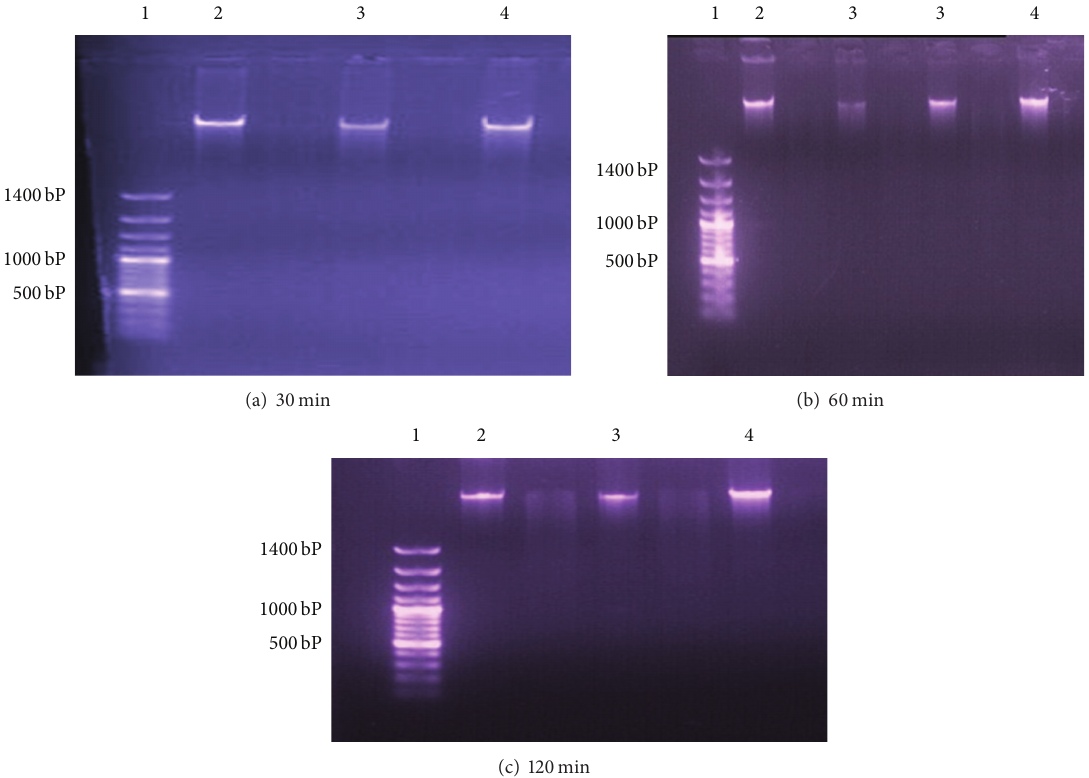
Figure 1: Showing the agarose gel electrophoresis of the isolated DNA of the parasites after incubating the blood with Ximenia americana extracts for 30, 60, and 120mins. Lane 1 DNA marker 100bp plus; Lane 2, treatment with 300 mg/mL aqueous extract; Lane 3, treatment with 25 mg/mL fraction IV portion; Lane 4, untreated